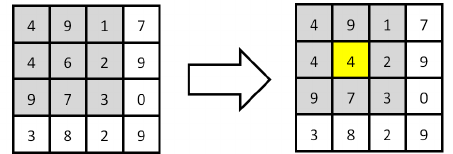
Figure 5. Median filtering.